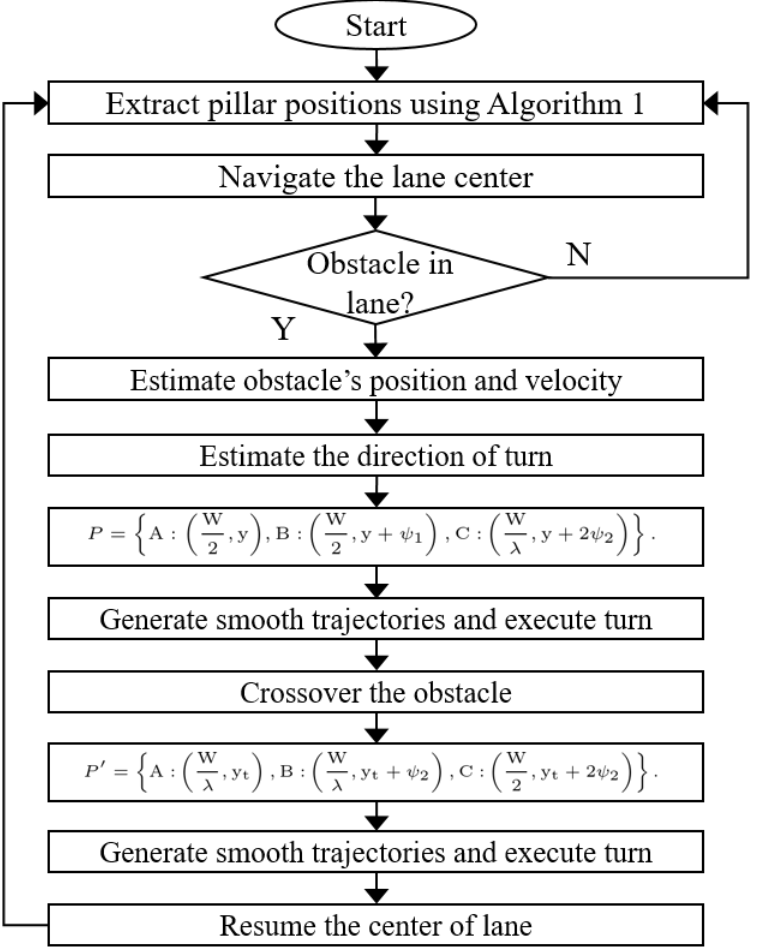
Figure 7. Flowchart of obstacle avoidance